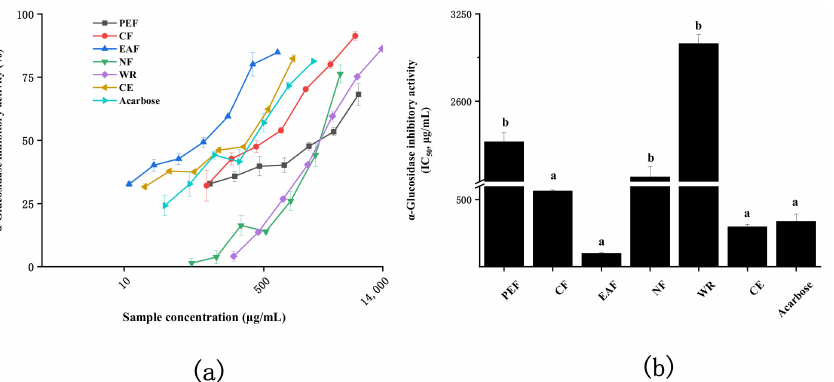
Figure 5. α -Glucosidase inhibitory activity of bioactive fractions from quinoa. ( a ) The inhibition rate of the α -glucosidase with different concentrations. ( b ) The IC 50 values of different samples toward α -glucosidase inhibitory activity. The different letters in the column represented significantly difference ( p <